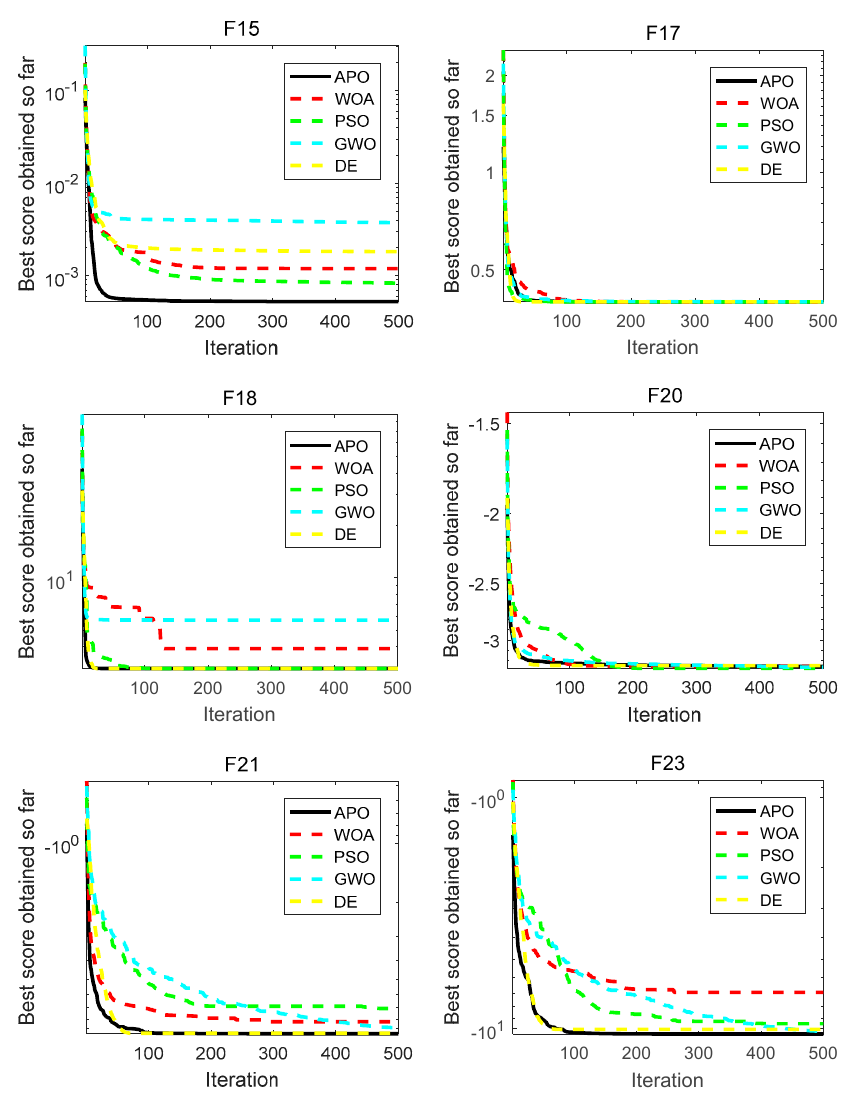
Figure 5. Evolution curves of the fitness value for some of the functions in Table 3.